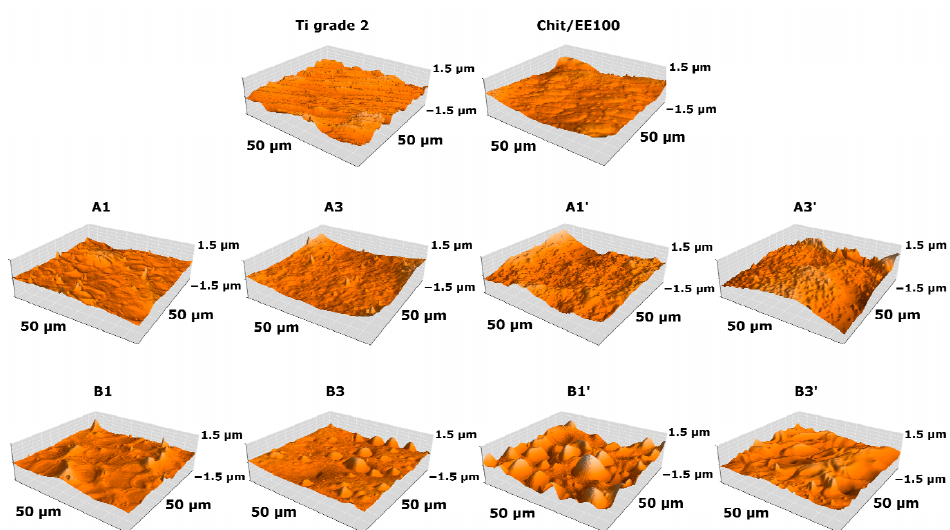
Figure 2. The surface topography of a bare titanium substrate, the chit/EE100 coating, and the set of chit/EE100/AgNPs coatings obtained by atomic force